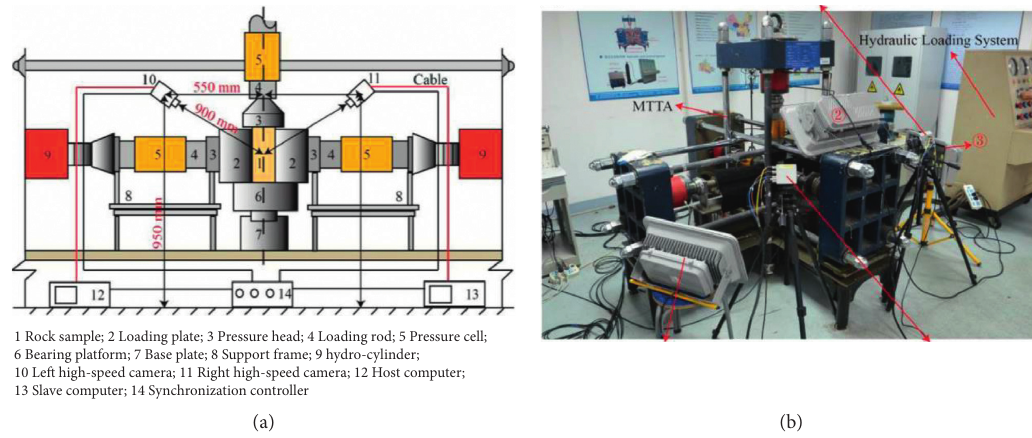
Figure 12: Schematic diagram of strain burst test system: (a) schematic diagram; (b) physical picture